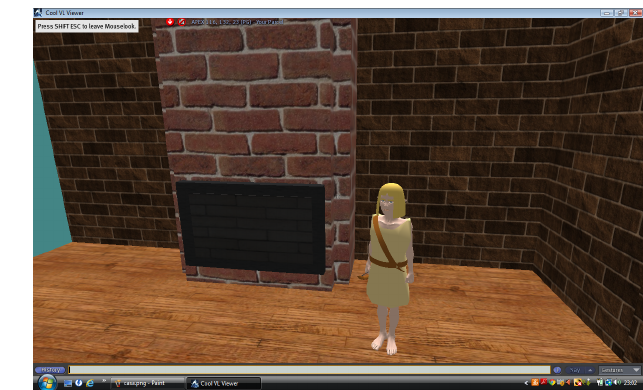
Figure 2. The Asthma game’s house (outside view)